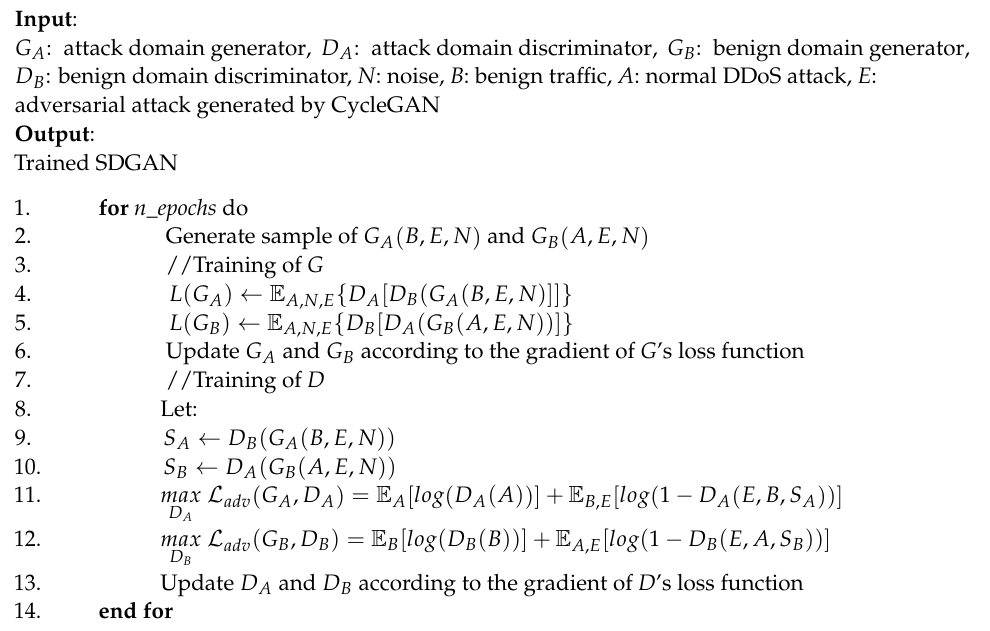
Algorithm 2. Algorithm for